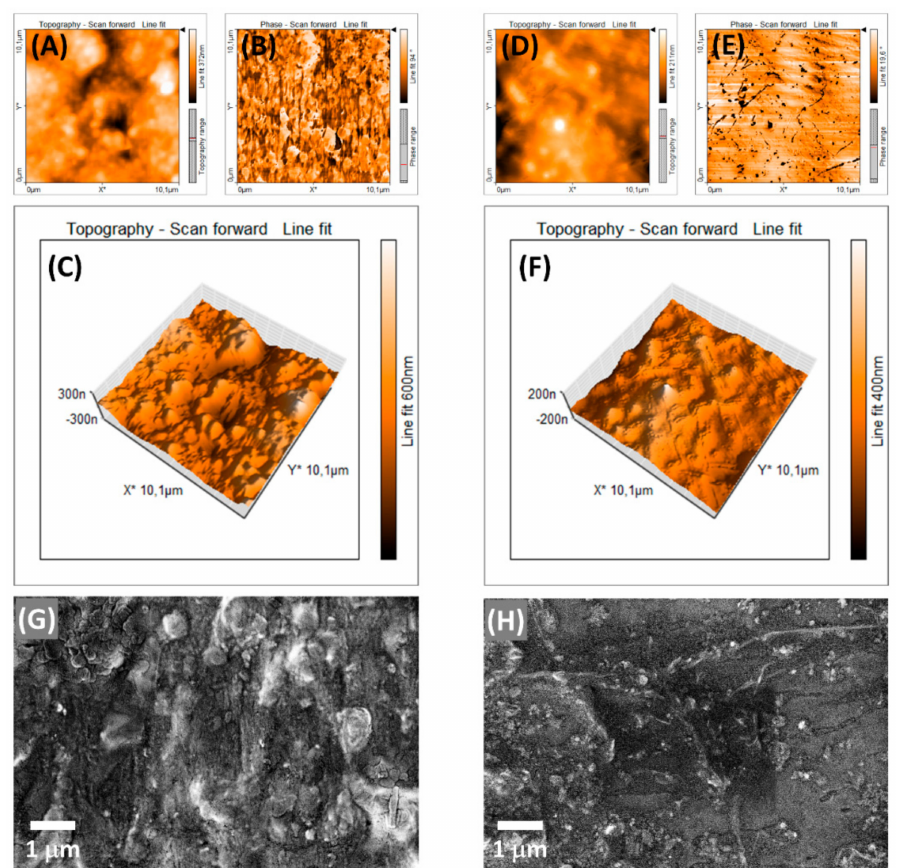
Figure 7. AFM images of ( A – C ) EVA and ( D – F ) EVA-SiO 2 -Ag samples. SEM images of the ( G ) EVA and ( H ) EVA-SiO 2 -Ag samples.